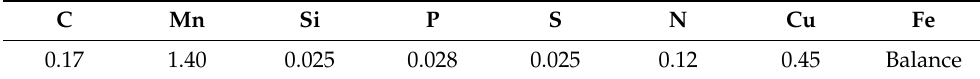
Table 1. Chemical composition of S235JR steel [%].